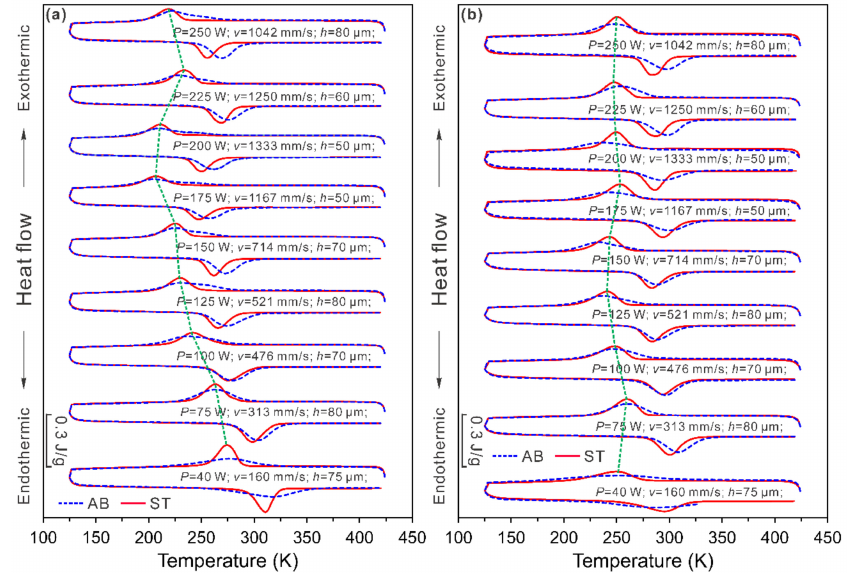
Figure 4. DSC (Differential Scanning Calorimetry) curves of the as-built (AB) and solution treated (ST, 1273 K for 2 h) NiTi samples produced by various SLM processes under ( a ) high O 2 and ( b ) low O 2 conditions. The green dash line guides the transformation peaks of the solution treated samples. P , v , and h represent the laser power, scanning velocity, and hatch spacing, respectively. (Modified after